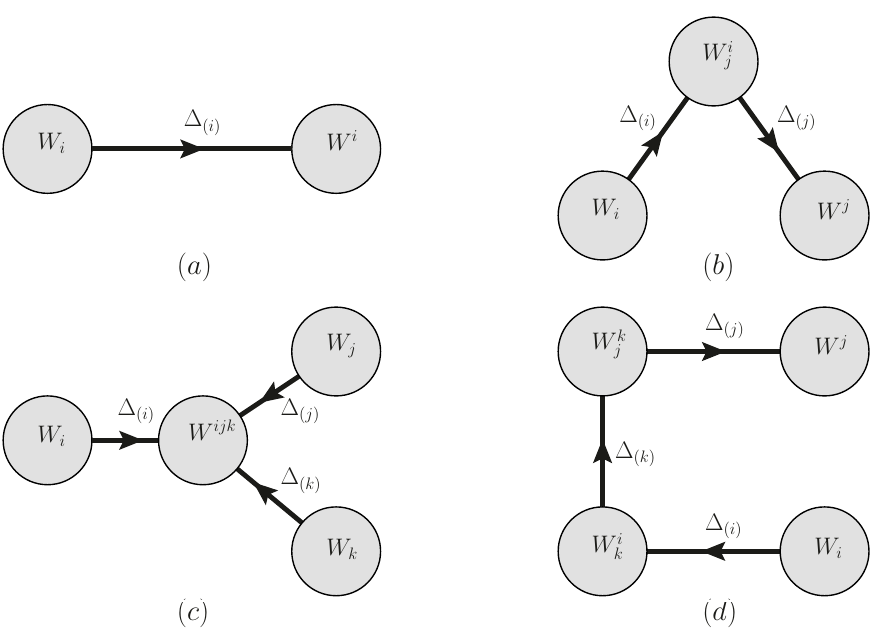
Figure 1 . Feynman diagrams contributing to L e(cid:11) to dimension n = 6. Non-equivalent permuta- tions of the arrow directions shown here should be considered as